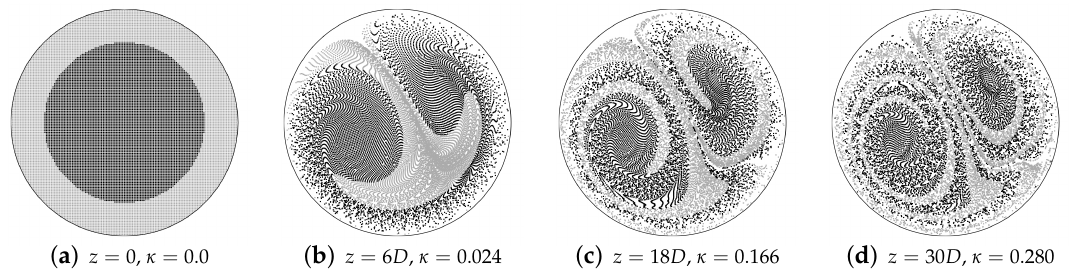
Figure 5. Coloured particle distributions taken at inlet and after one, three, and five pitch lengths of a single helix for R = 0.25 D —though the particles are gradually mixed with each iteration, the double vortex structure of the secondary flow remains visible even after five pitch lengths. The relevant value of κ is shown below each particle trajectory slice. (Reprinted by permission from: Springer, Annals of Biomedical Engineering, DOI: 10.1007/s10439-009-9636-y, Mixing through stirring of steady flow in small amplitude helical tubes, A. N. Cookson, D. J. Doorly, S. J. Sherwin, ( c (cid:13)